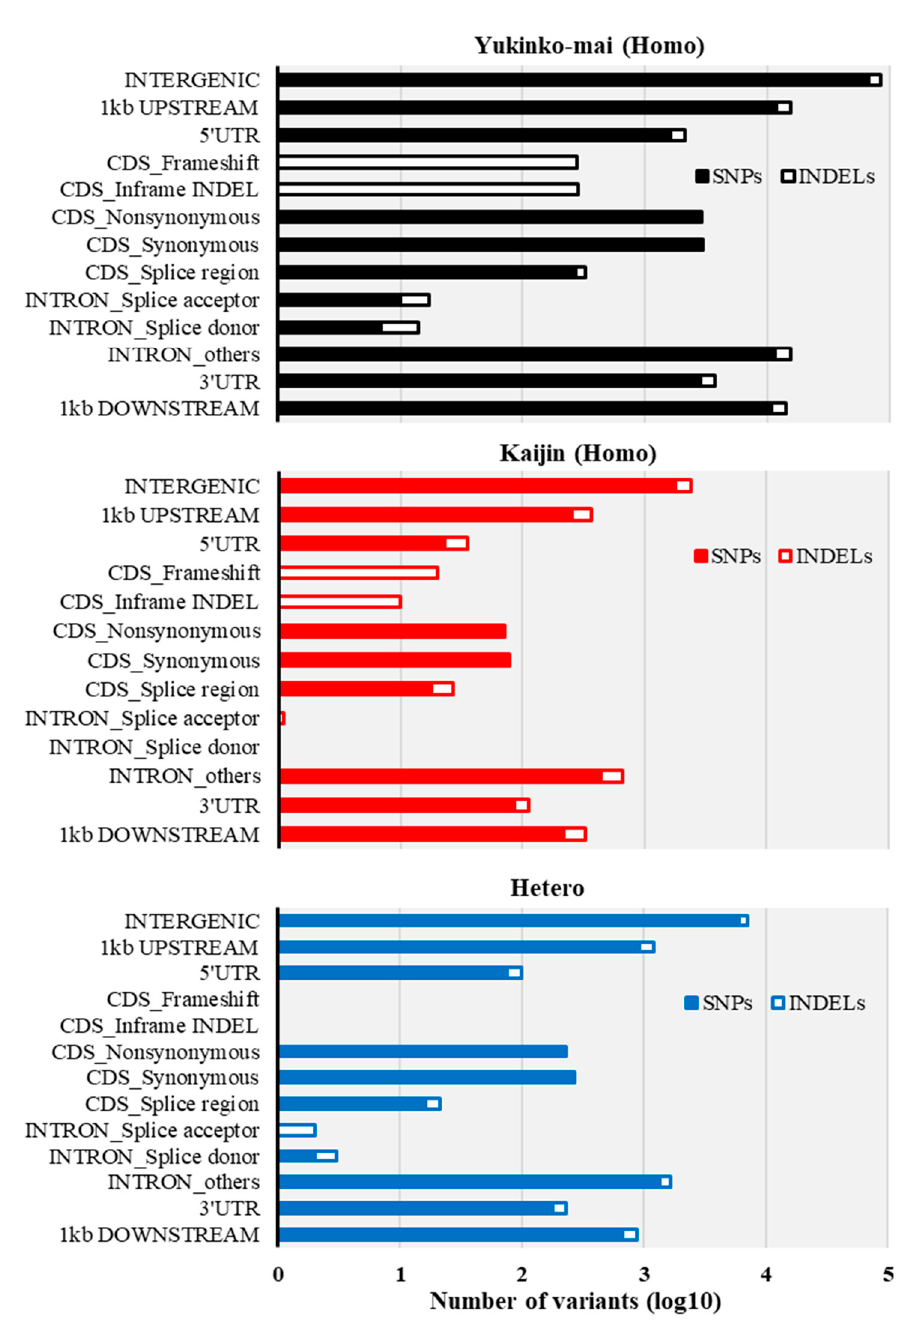
(colour). Black, “Yukinko-mai”-type homozygous; red, “Kaijin”-type homozygous; blue, heterozygous. Green bars represent chromosome length.